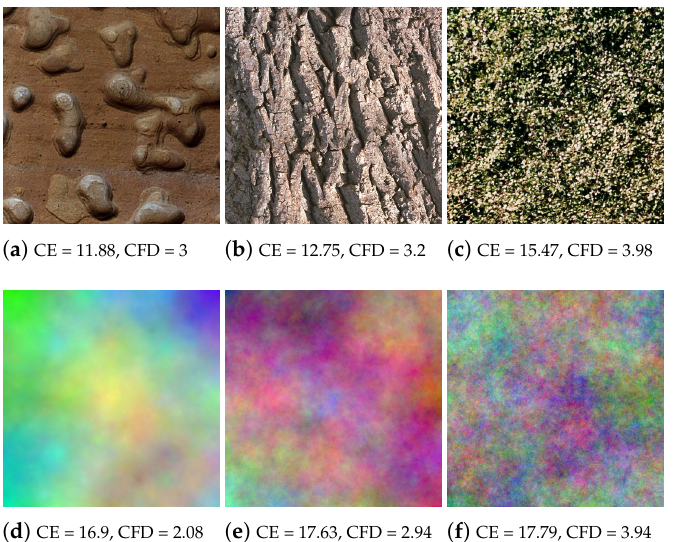
Figure 2. Stimuli images examples: Top natural textures (Nat) and synthetic fractal textures (Frac)